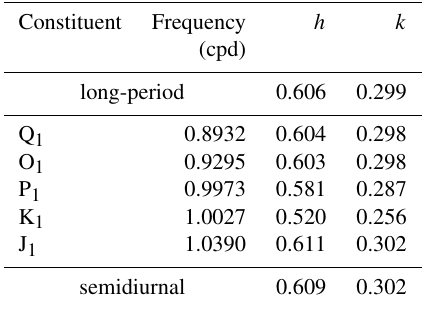
Table 1. Love numbers for the major tidal constituents (Wahr, 1981; Kantha and Clayson, 2000). “cpd” is cycles per day.